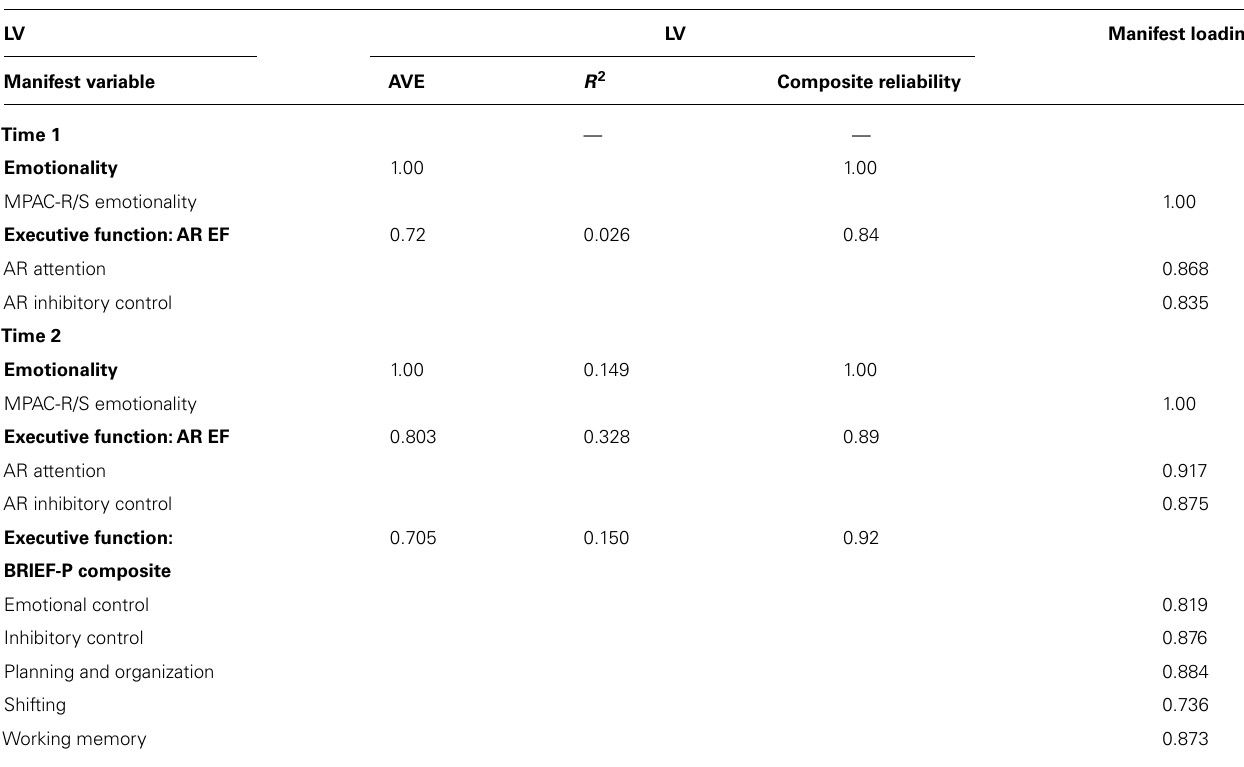
Table 2 | Outer model and final R 2 s for latent variables.